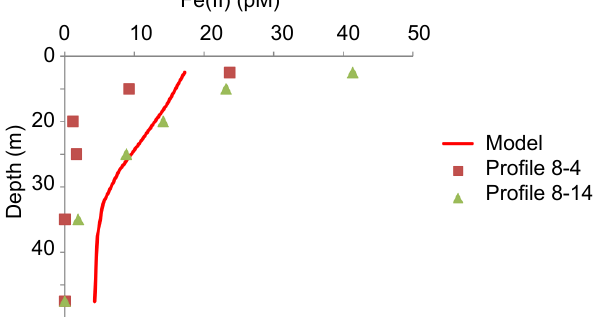
FIGURE 7 Fig. 7. A profile of modeled Fe(II) alongside profiles 8–4 (47 ◦ 35.852 0 N 165 ◦ 58.760 0 E) and 8–14 (47 ◦ 51.220 0 N 166 ◦ 15.244 0 E) presented in Roy et al. (2008).